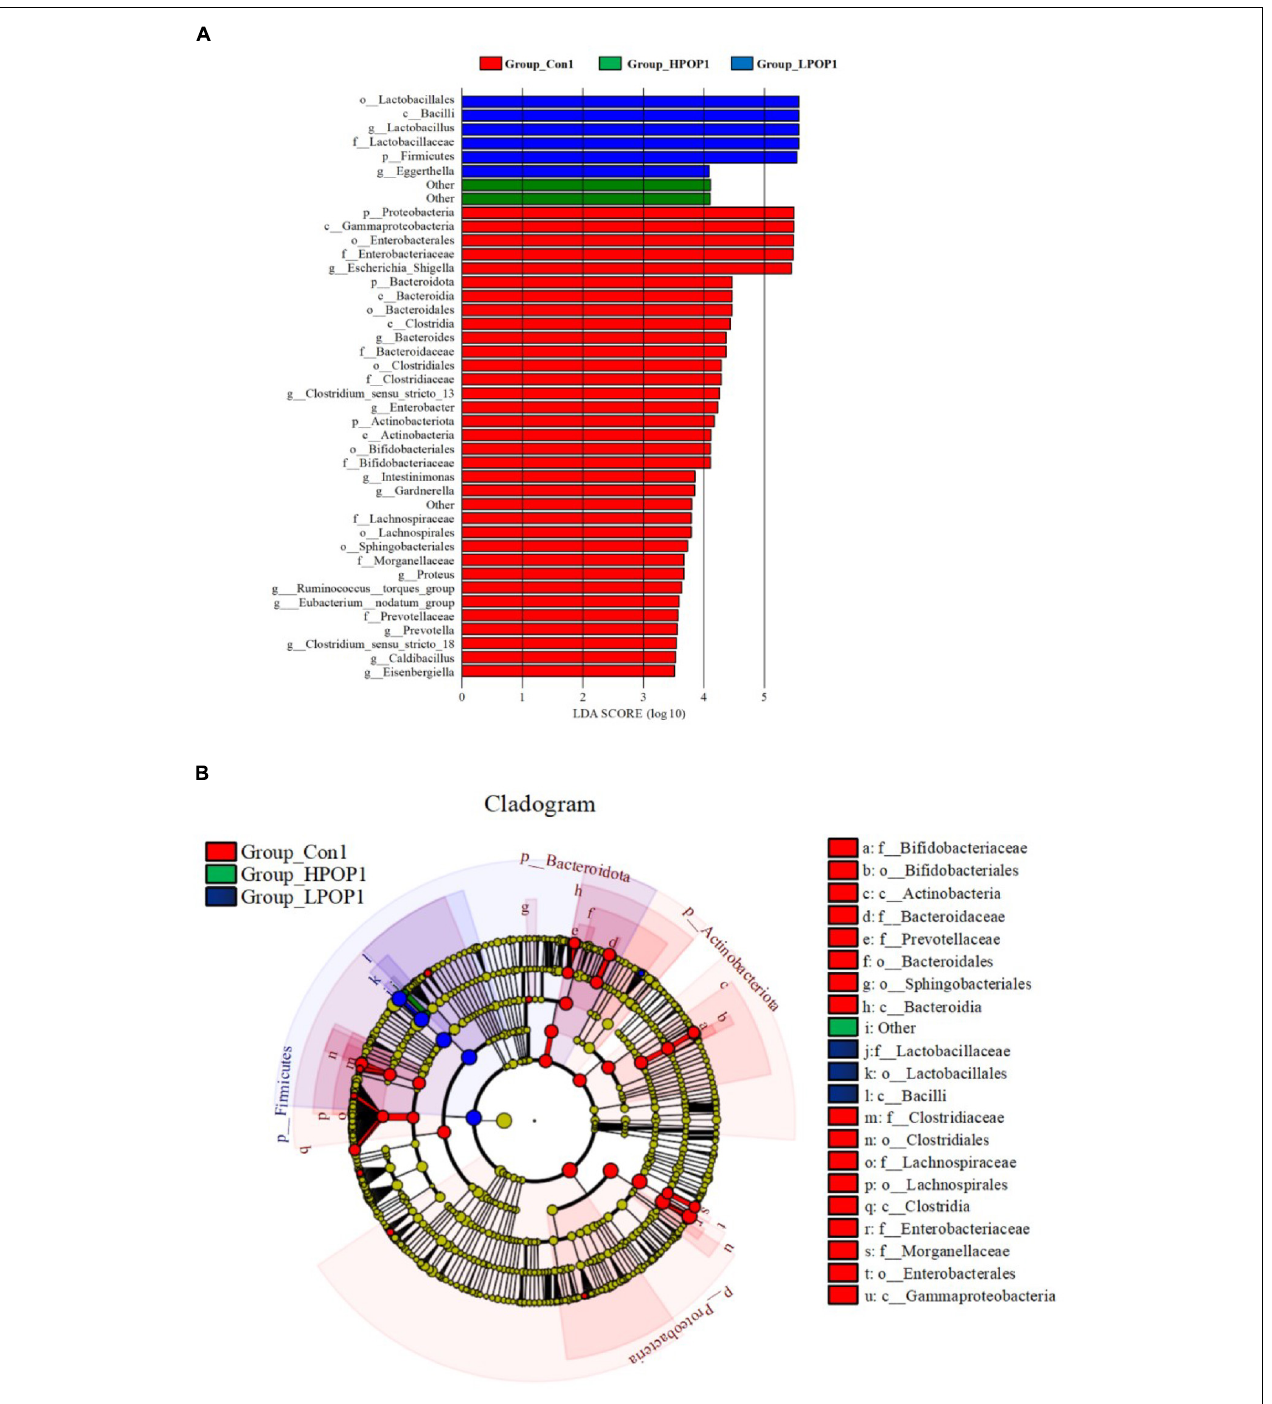
FIGURE 6 | LEfSe analysis showing the most differentially abundant taxa (LDA score > 3.0) after 24 h in vitro fecal fermentation with POP. (A) Histogram of the LDA scores. (B) Taxonomic cladogram of all differentially abundant taxa across all taxonomic levels [from the inner to outer rings, phylum (p), class (c), order (o), family (f), and genus